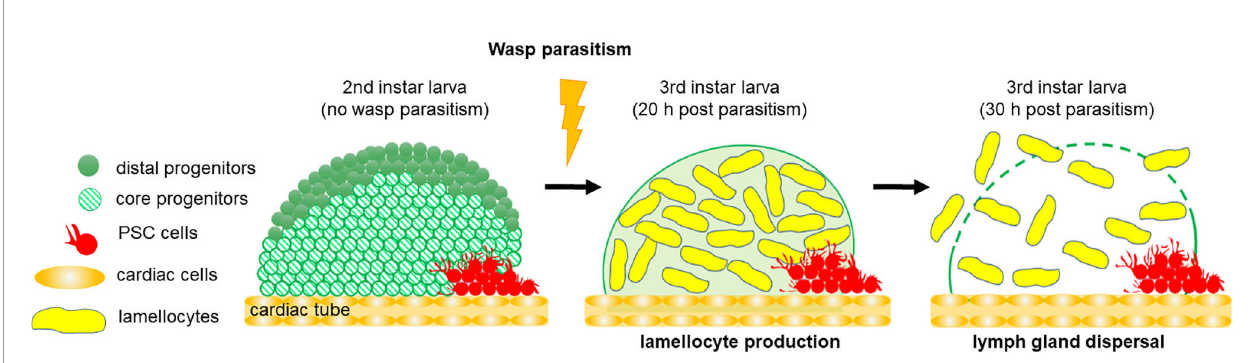
FIGURE 3 | Lymph gland response to wasp parasitism. Schematic representation of 2 nd instar larval lymph gland, composed of PSC cells and progenitors. Twenty hours post parasitism, lamellocytes differentiate at the expense of progenitor maintenance. Thirty hours post parasitism, the lymph gland disrupts and cells are released into the hemolymph, where they encapsulate the wasp